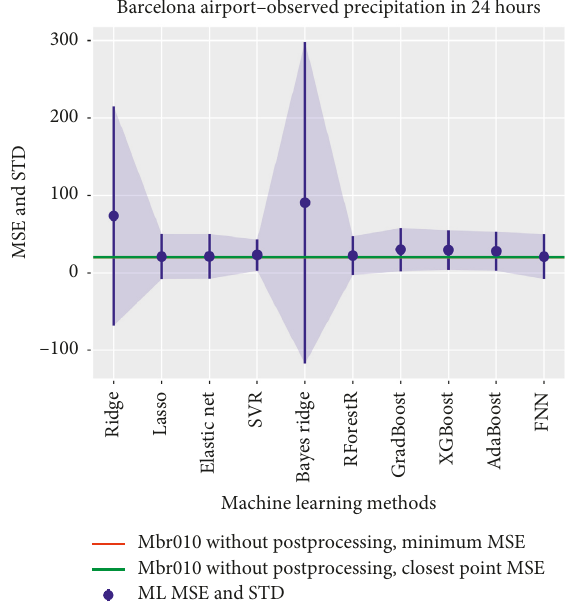
Figure 19: Precipitation in 24hours, calibration plot for Barcelona airport. Horizontal axis as in Figure